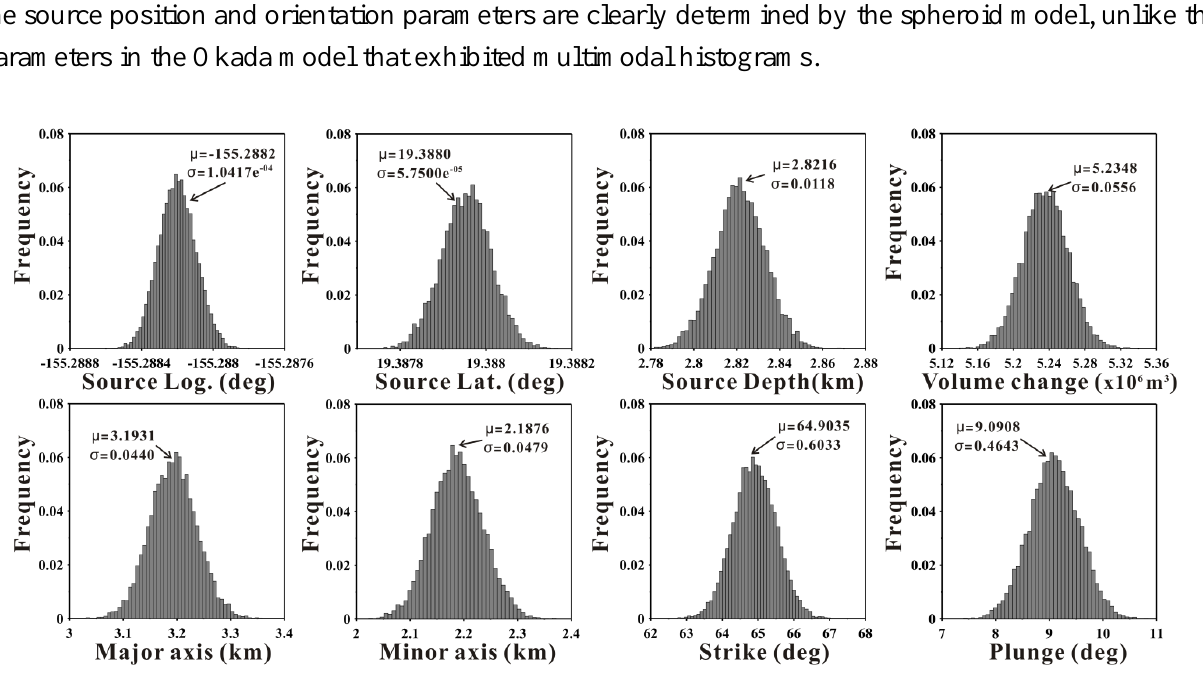
Figure 8. Histograms of the magma source parameters estimated from the 3D measurement inputs using prolate spheroid